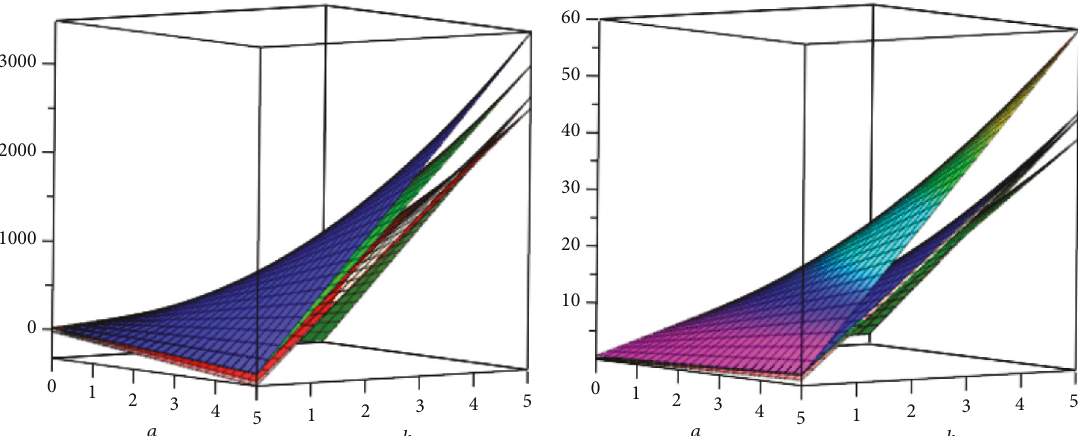
Figure 10: Variations of the GHI and HGI for Si